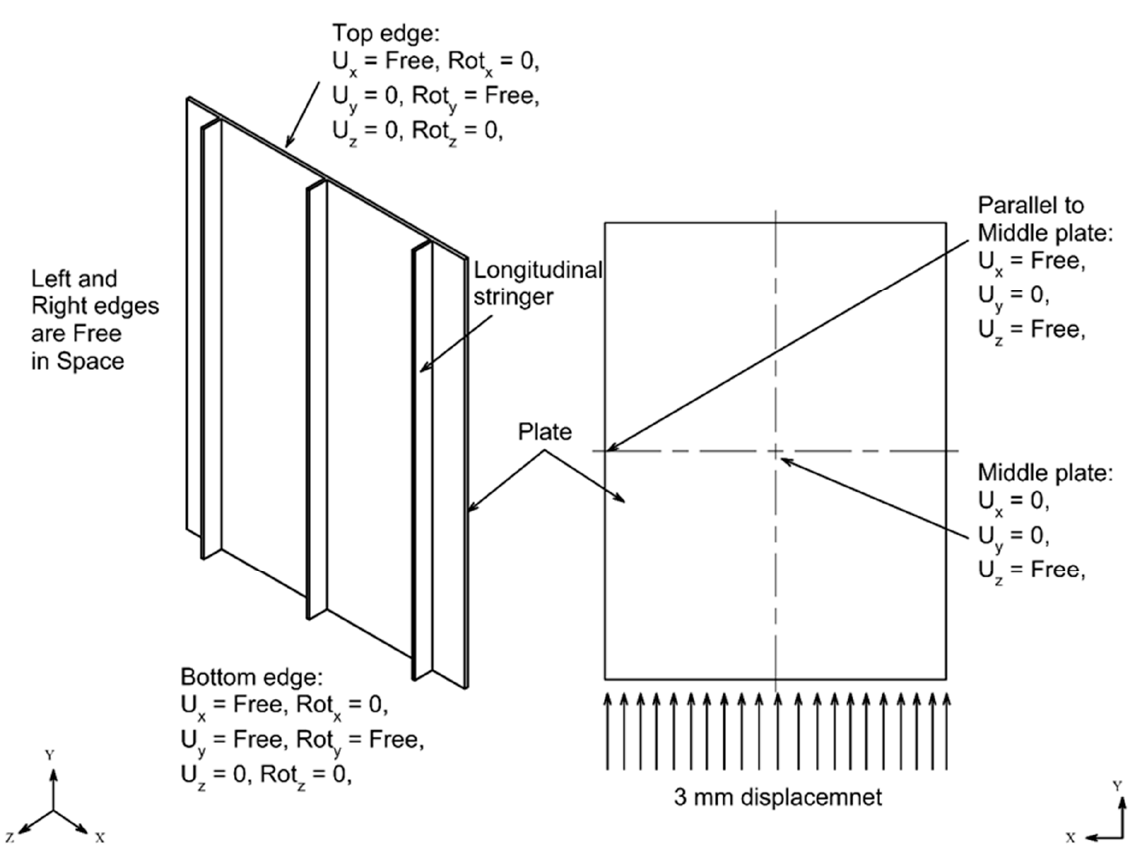
Figure 14. Nonlinear boundary condition on Specimen A.